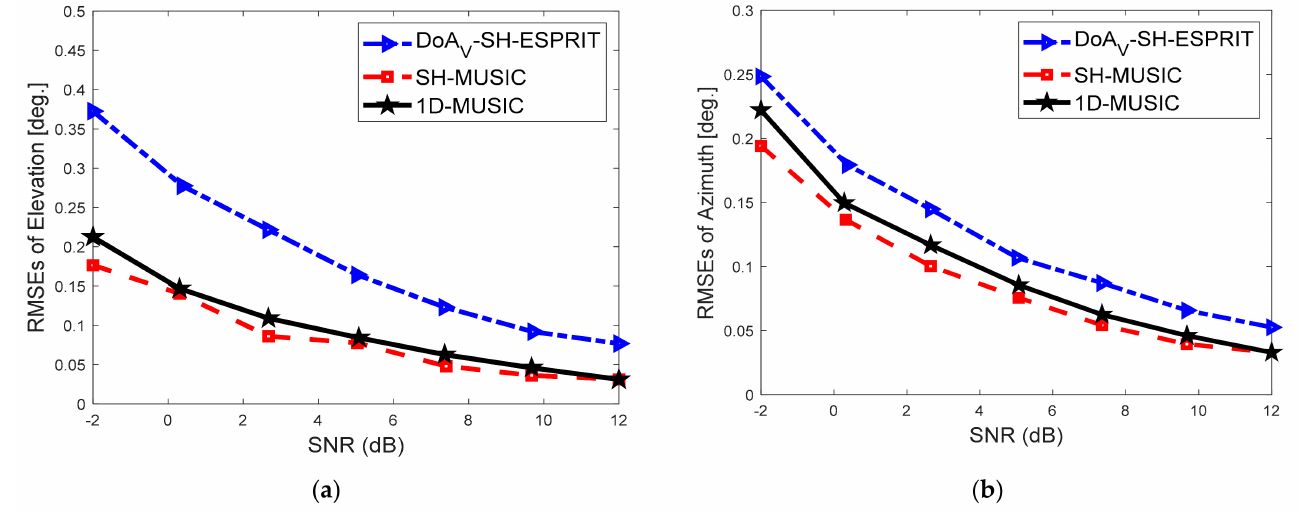
Figure 8. RMSEs estimation versus SNR with two sources ( a ) Elevation ( b )